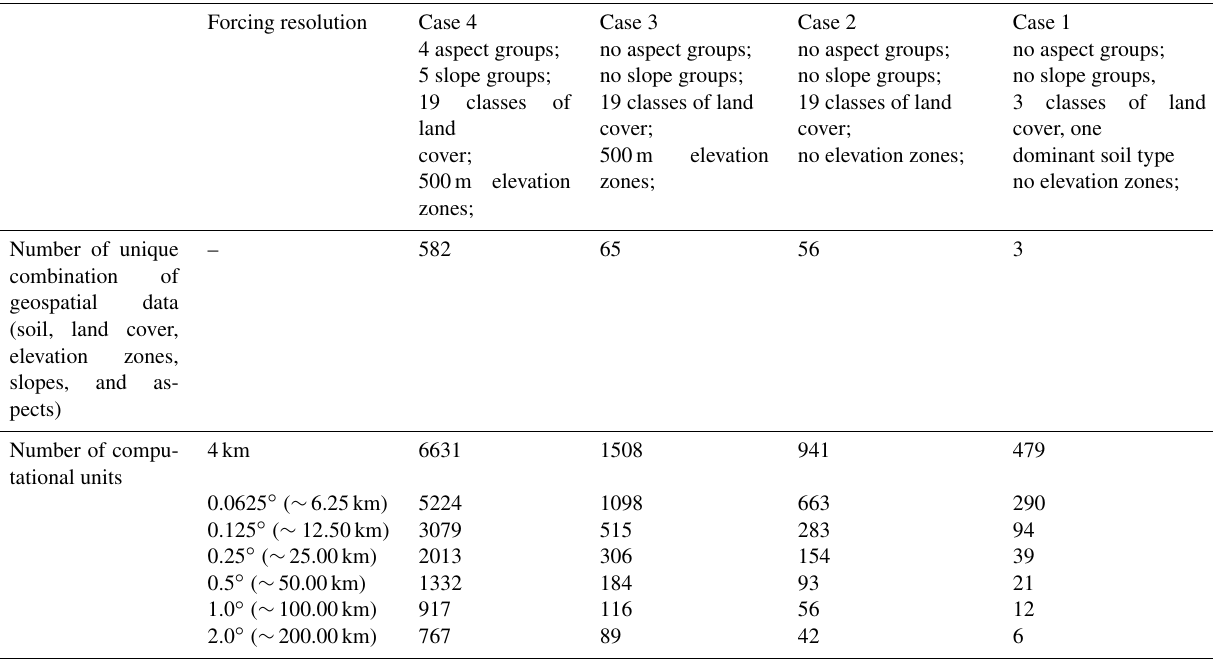
Table 2. The numbers of computational units for the Bow River at Banff, given different spatial discretization of land cover, soil type, elevation zones, slopes, and aspects forced with various forcing